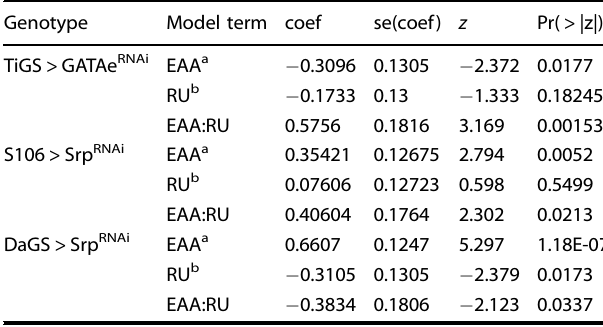
Table 3. Cox proportional hazards analysis of DR × GATA RNAi lifespan